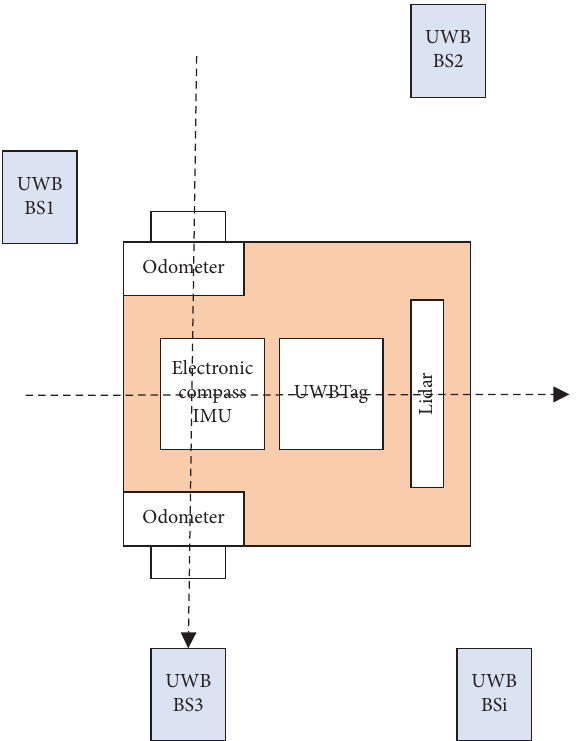
Figure 2: Schematic diagram of the mobile robot positioning